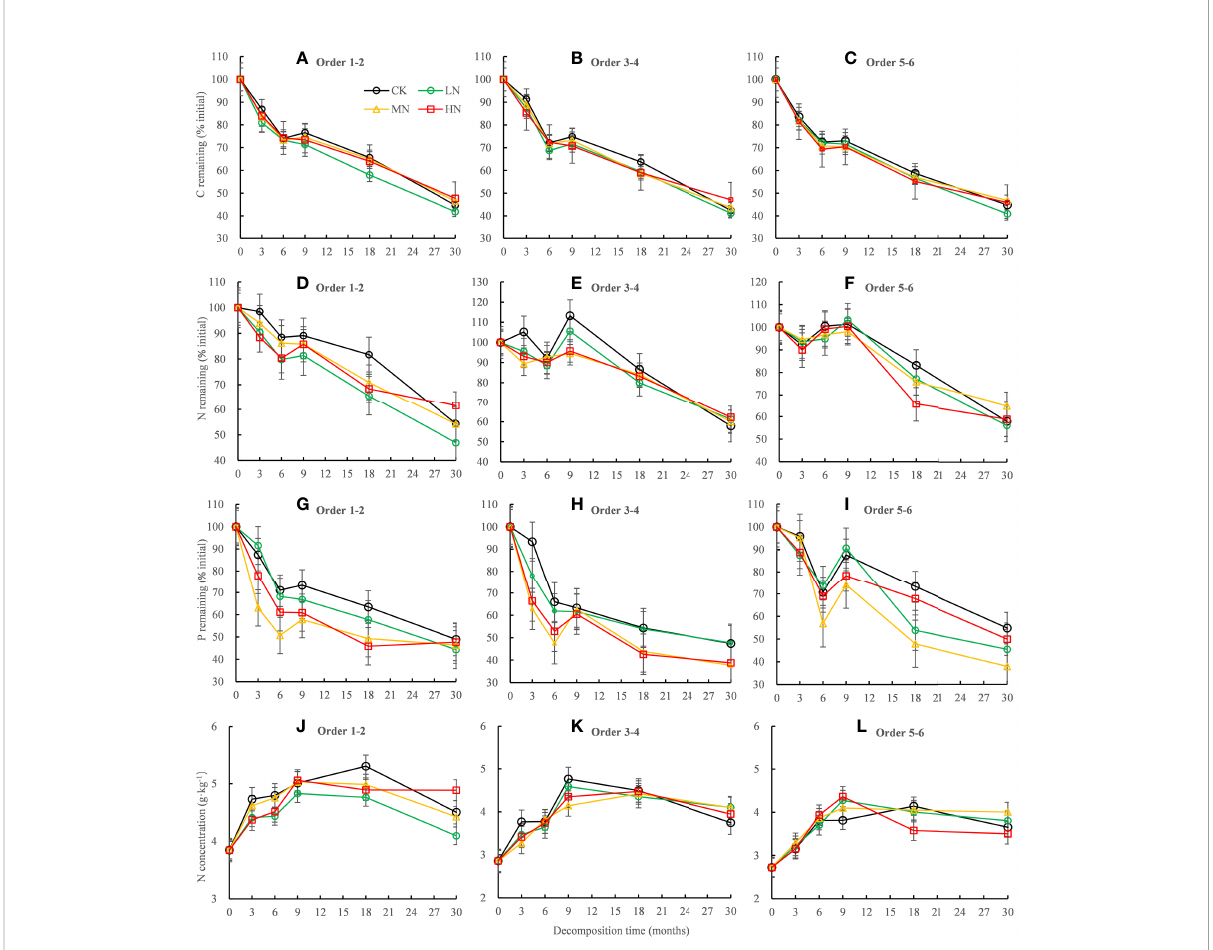
FIGURE 2 Residual percentages of C, N, and P and absolute concentrations of N during the 30-month fi ne root decomposition of Pinus massoniana in different N addition treatments. Values are means ± SE. The different colors denote CK (0 kg ha -1 year -1 ), LN (30 kg ha -1 year -1 ), MN (60 kg ha -1 year -1 ), and HN (90 kg ha -1 year -1 ). (A – I) represent the residual percentages of C, N, and P in order 1-2, order 3-4 and order 5-6 fi ne roots, respectively. (J – L) represent the absolute concentrations of N in order 1-2, order 3-4 and order 5-6 fi ne roots, respectively.